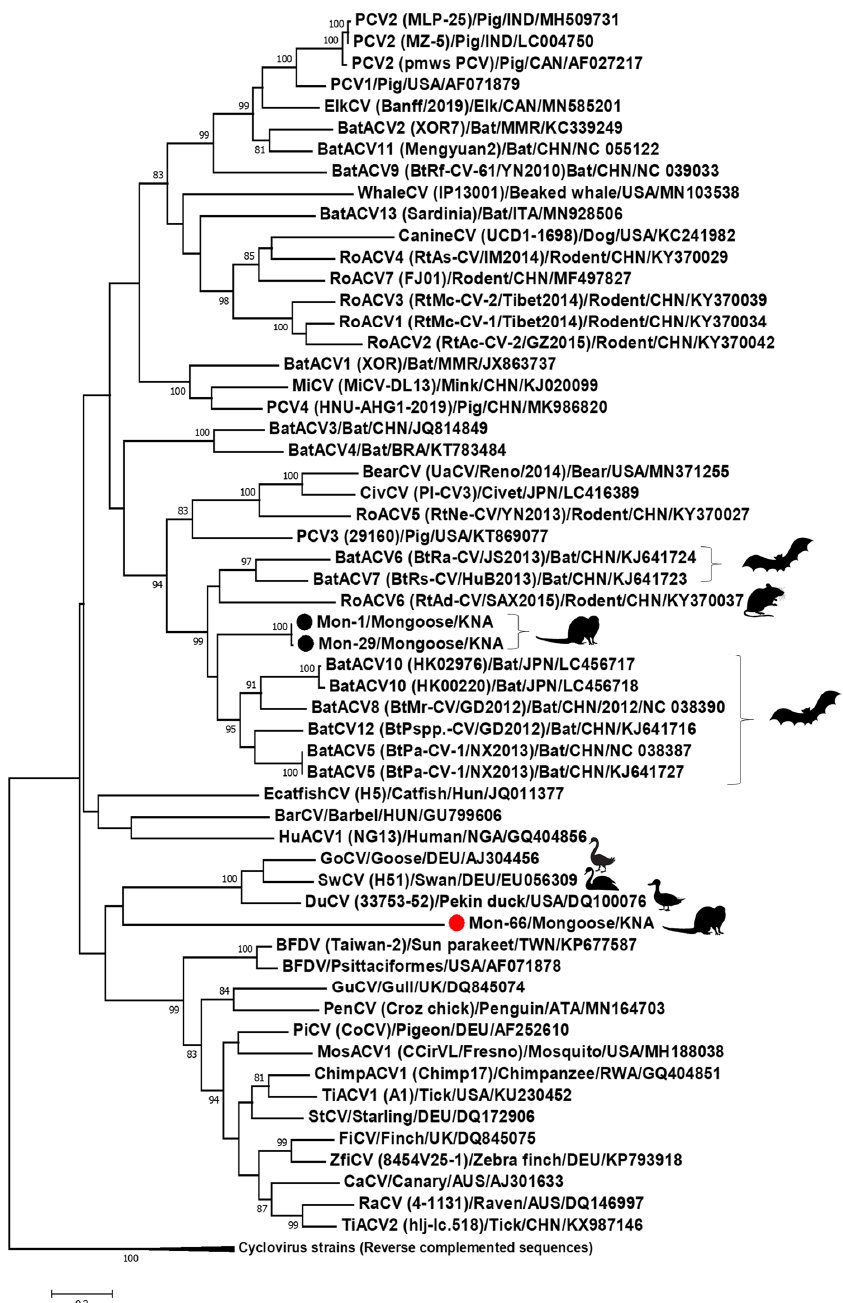
Figure 5. Phylogenetic analysis of the complete genomes of mongoose associated circoviruses (Mon-1, -29 and -66) with those of other circoviruses. The virus name/source (detected in animal species)/country are shown for the Mon sequences, while the species, or virus name (isolate)/source (detected in animal species)/country/GenBank accession number have been mentioned for the other circovirus sequences. The tree was constructed by the maximum likelihood (ML) method, with the GTR+G model of substitution and 1000 bootstrap replicates and rooted after using cyclovirus reverse complemented sequences as the outgroup. Scale bar, 0.2 substitutions per nucleotide. Bootstrap values of <80 is not shown. Mon-1 and -29 are shown with black circles, whilst Mon-66 is highlighted with a red circle. BarCV: barbel circovirus; BatACV: bat associated circovirus; BFDV: beak and feather disease virus; CaCV: canary circovirus; ChimpACV: chimpanzee associated circovirus; CivCV: civet circovirus; CV: circovirus; DuCV: duck circovirus; EcatfishCV: European catfish circovirus; ElkCV: elk circovirus; FiCV: finch circovirus; GoCV: goose circovirus; GuCV: gull circovirus; HuACV: human associated circovirus; MiCV: mink circovirus; MosACV: mosquito associated circovirus; PenCV: penguin circovirus; PCV: porcine circovirus; PiCV: pigeon circovirus; RaCV: raven circovirus; RoACV: rodent associated circovirus; StCV: starling circovirus; SwCV: swan circovirus; TiACV: tick associated circovirus; ZfiCV: zebra fish